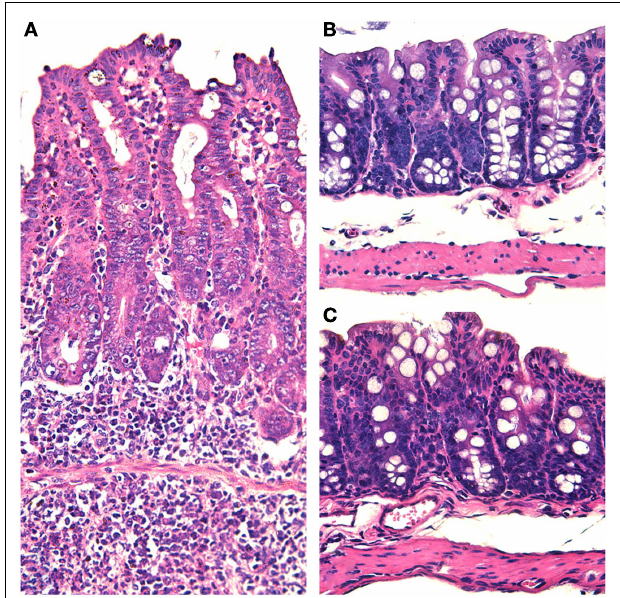
FIGURE 2 | Salmonella -induced typhlitis in mice with dysbiotic microbiota due to streptomycin treatment . (A) Marked thickening of the cecal wall with edema and increased cellularity due to a diffuse infiltration of inflammatory cells in a mouse with dysbiosis (pre-treated with streptomycin) and intragastrically infected with Salmonella enterica serotypeTyphimurium. (B) Section of the cecum from a mouse intragastrically infected with Salmonella enterica serotypeTyphimurium in the presence of a normal microbiota with no histopathological changes. (C) Section of the cecum from a healthy non-infected mouse. Note that all micrographs have the same magnification 20 × objective. Hematoxylin and